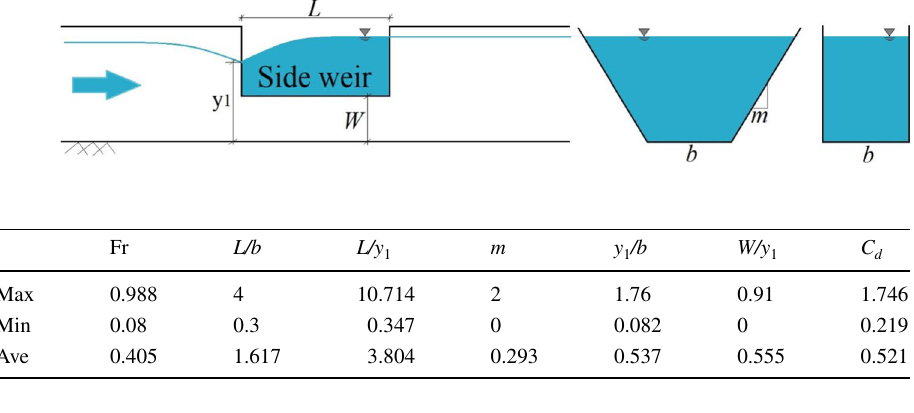
Fig. 2 Layout of used experi- mental models